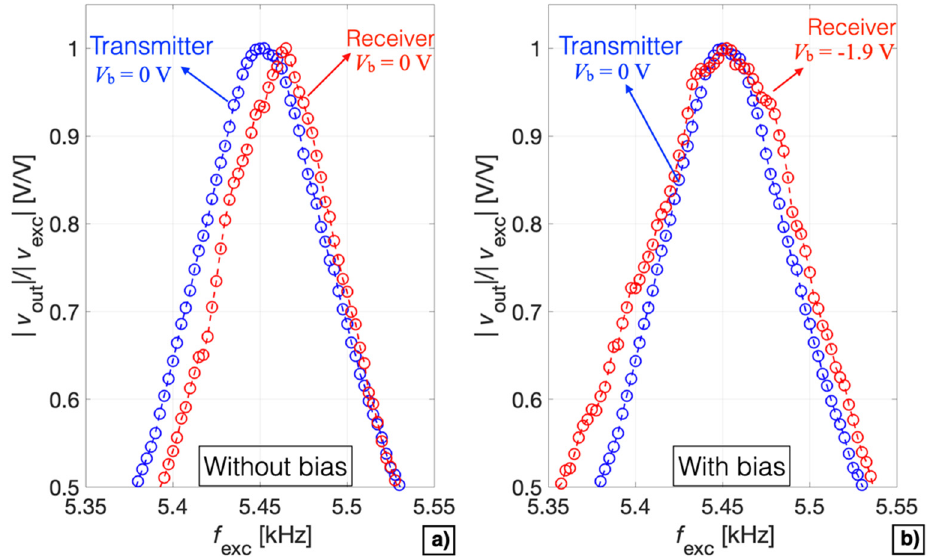
Figure 17. Comparison between the receiver and transmitter mode in terms of the normalized measured magnitude ratio as a function of the frequency f exc without ( a ) and with ( b ) the tuning effect induced by V b . effect induced by V b